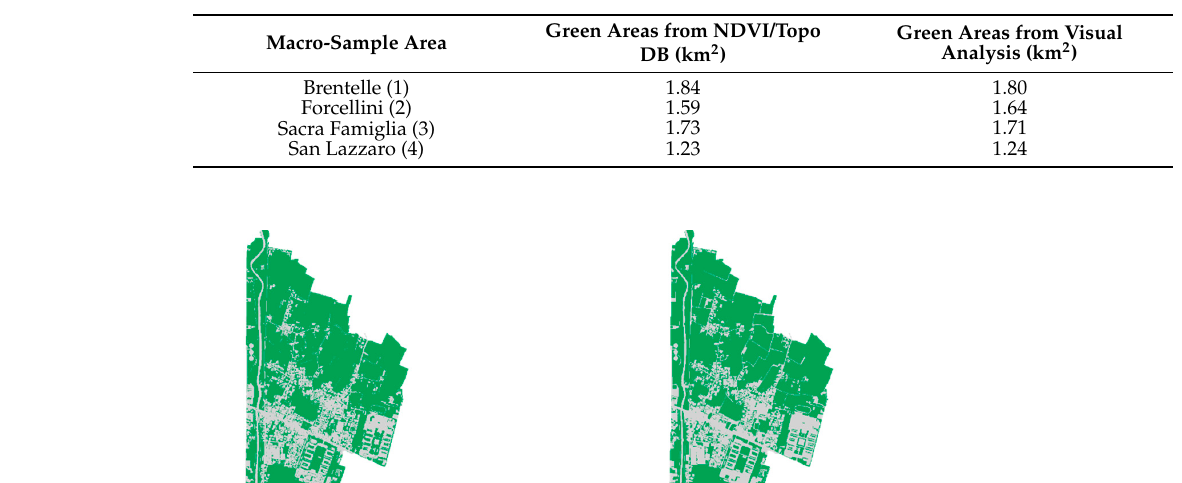
Table 2. Green surfaces from NDVI and from visual analysis in the four sample areas.